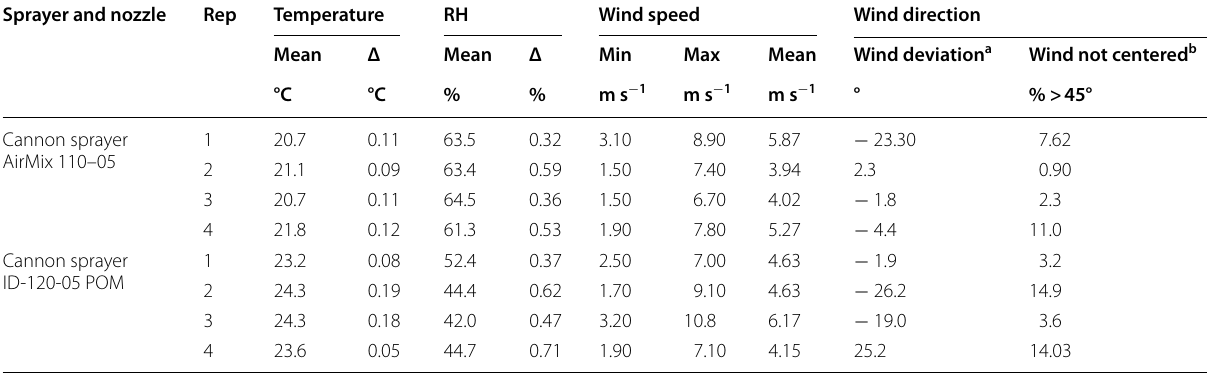
a The mean wind direction must not deviate more than 30° from the perpendicular to the direction of travel b No more than 30% of the individual values may deviate more than 45° from the perpendicular to the direction of travel